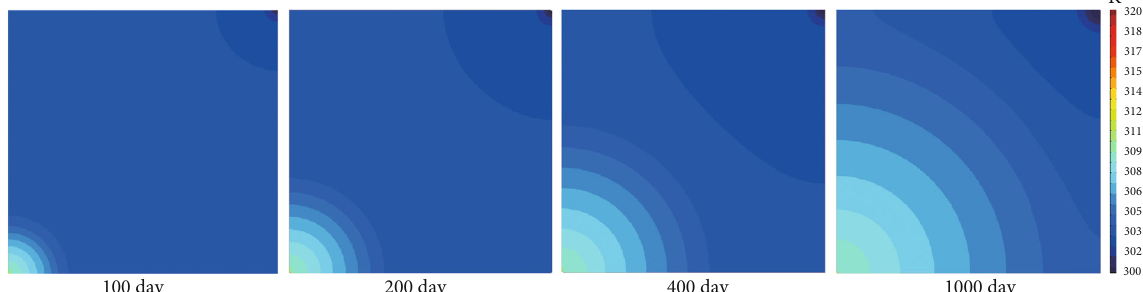
Figure 23: Distribution of temperature during hot CO